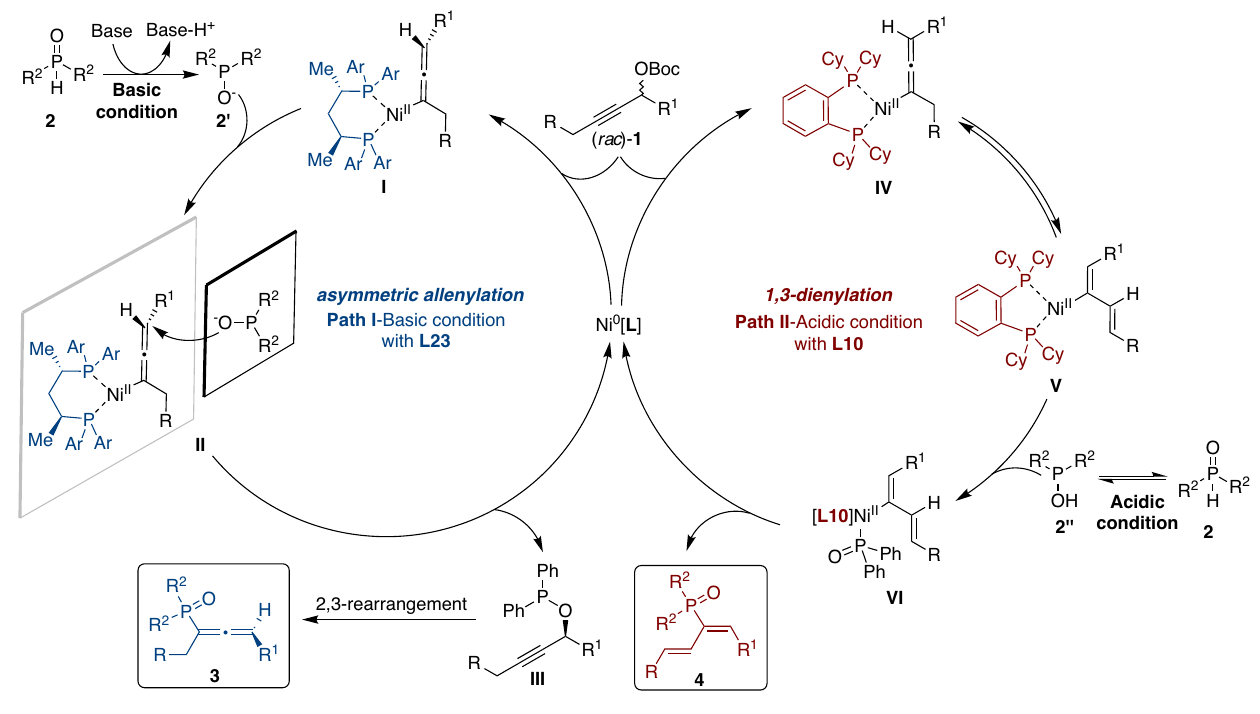
Fig.7|Proposedcatalyticcycle. Pathwaysareshownforthecatalyticallyafforded reactive species from propargylic carbonate with nickel catalysts. Under basic condition, the phosphine L23 -bound allenylnickel intermediate I can react with